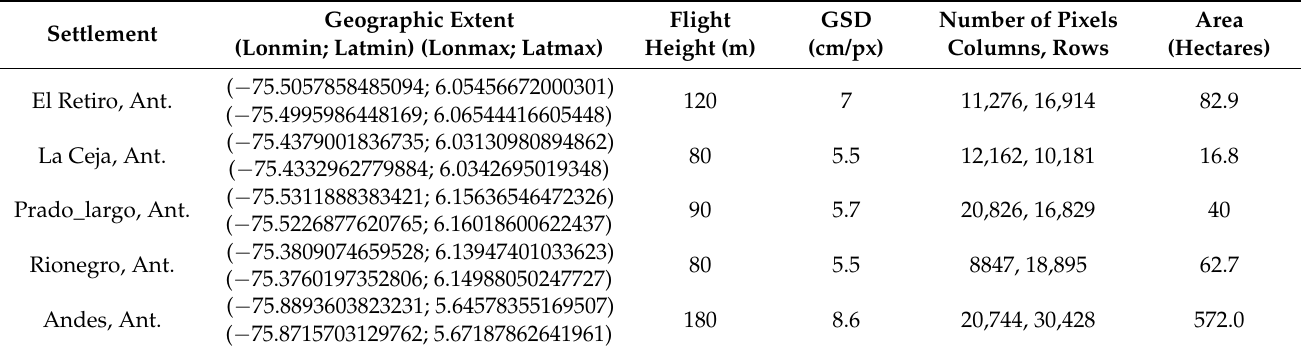
Figure 4. Acquired drone imagery. Orthomosaic ( left ), DSM ( center ), vector roads ( right ). Table 1. Drone imagery metadata.